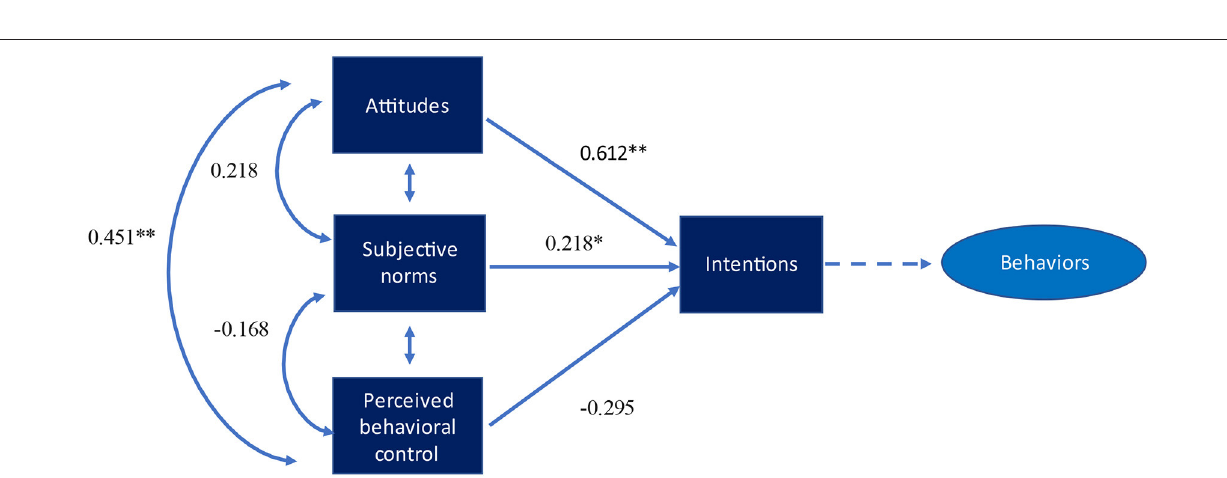
Frontiers in Medicine |